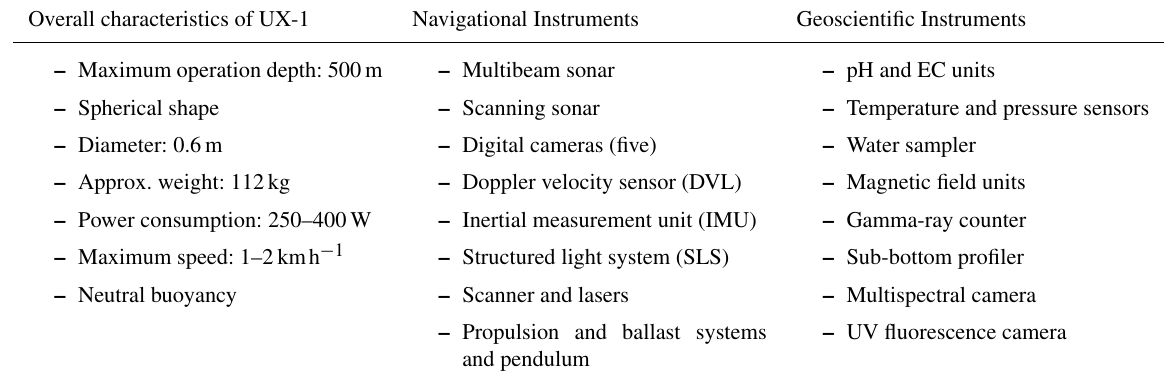
Table 1. UX-1 characteristics and